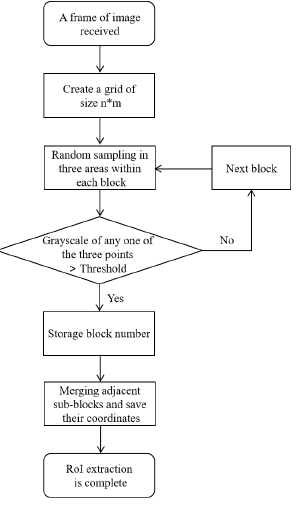
Figure 5. Flow chart of the proposed